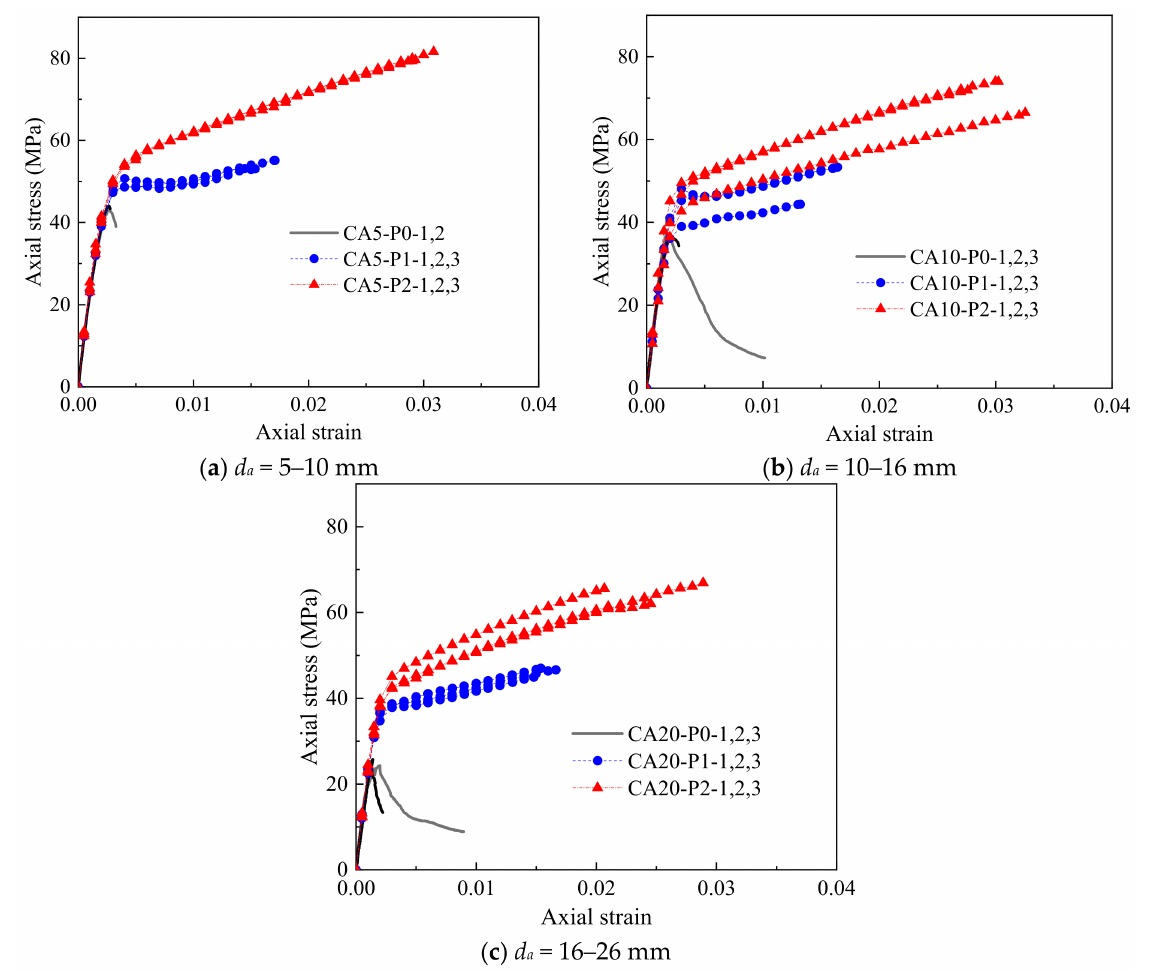
Figure 5. Effect of FRP thickness on stress–strain behavior of confined